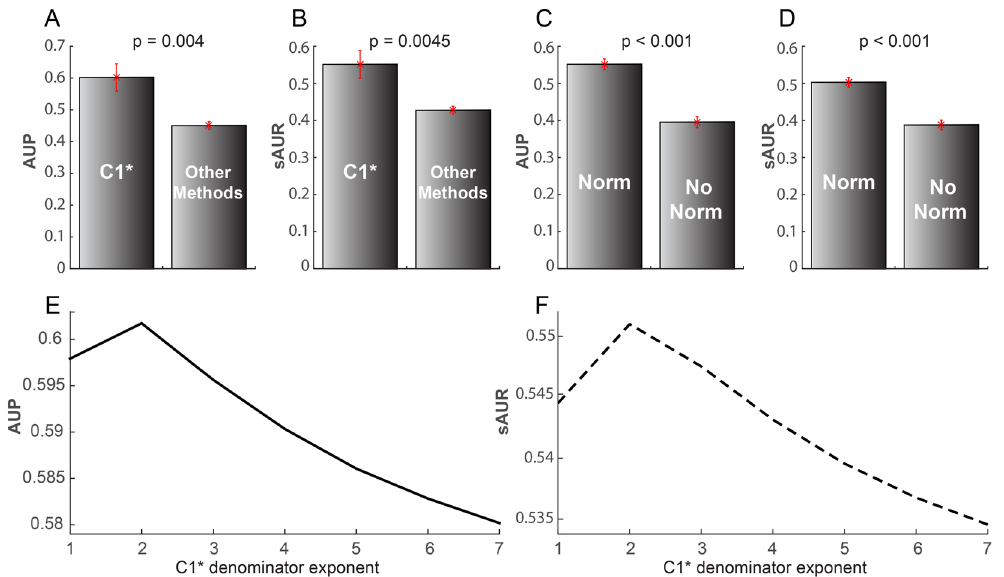
Figure 5. ( A,B ) Comparison between C1 * mean performance and the mean performance of the other methods across all the networks according to AUP and sAUR. ( C,D) Comparison between the mean performance of normalized and non-normalized methods across all the networks according to AUP and sAUR. The standard error is reported as a red colour deviation on top of each bar that indicates the mean value. P-values are reported on top of each panel, indicating the level of significance of the comparison. ( E,F) mean AUP and sAUR values across all the networks computed for the C1 * algorithm considering different denominator